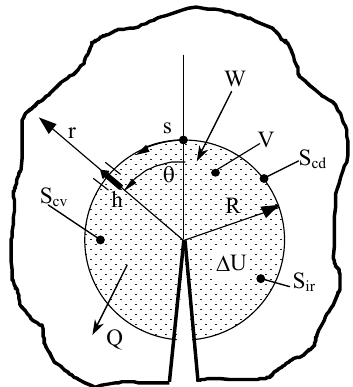
Figure 1: Energy balance for a volume of material V surrounding a crack tip subject to fatigue